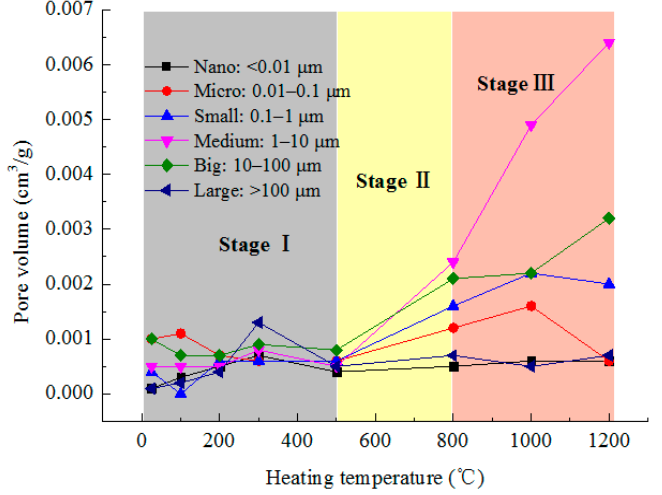
Figure 9. Volume change of the six types of pores in granite samples with increasing temperature.